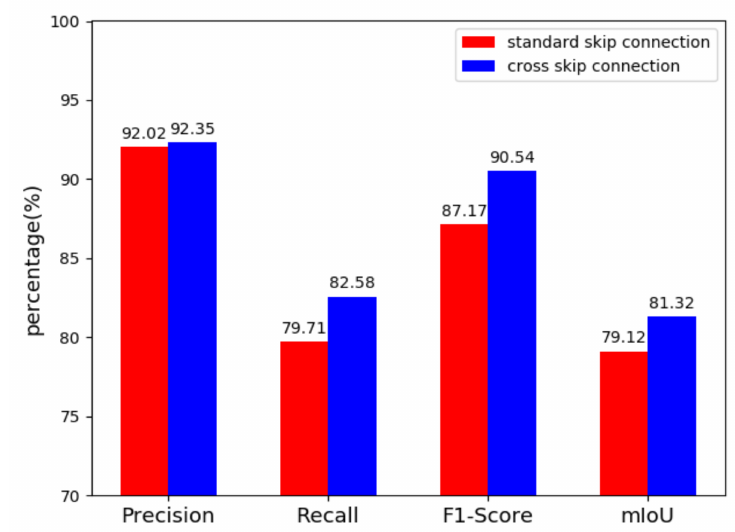
Figure 11. Comparison of experimental results of two types of skip